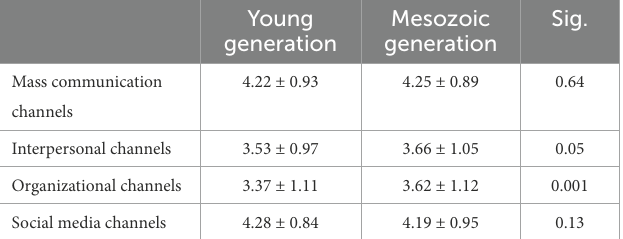
TABLE 3 An analysis of differences in media exposure between generations.